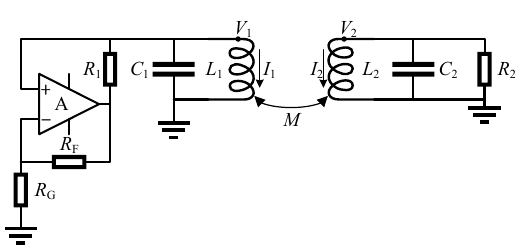
Figure 1. Block diagram of the circuit of a typical nonlinear parity-time-symmetric wireless power (NPTS-WPT) system.